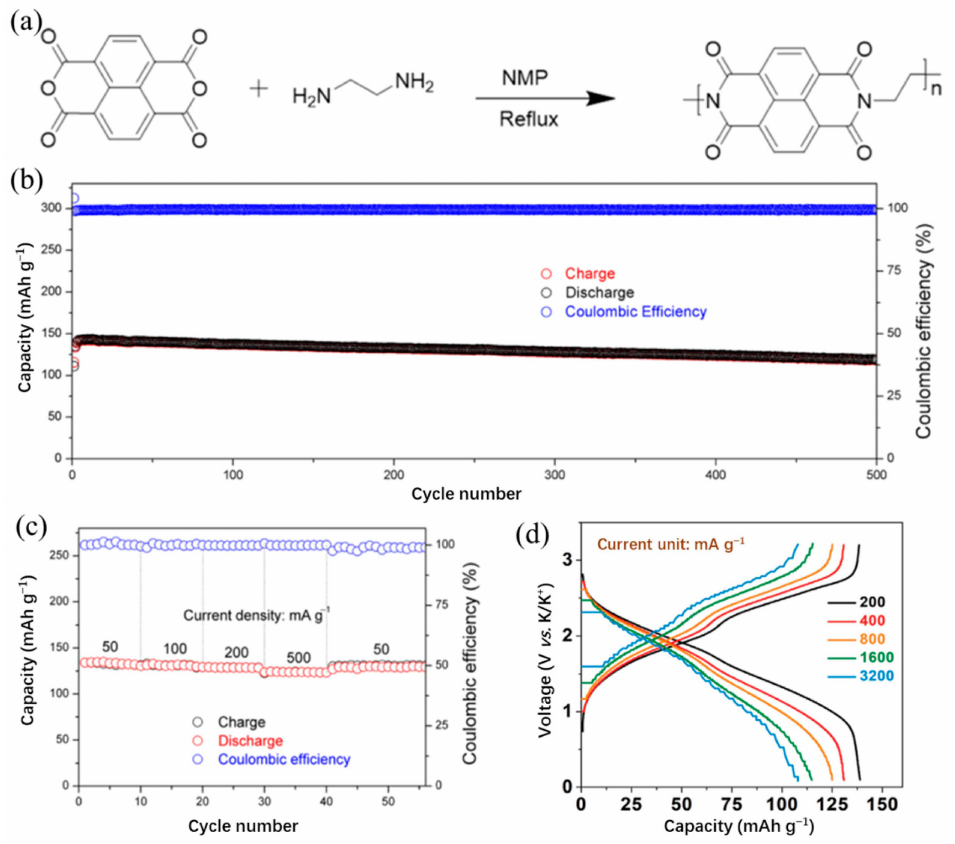
Figure 4. ( a ) Schematic diagram of synthesis process of PI. ( b ) Long-term cycling performance